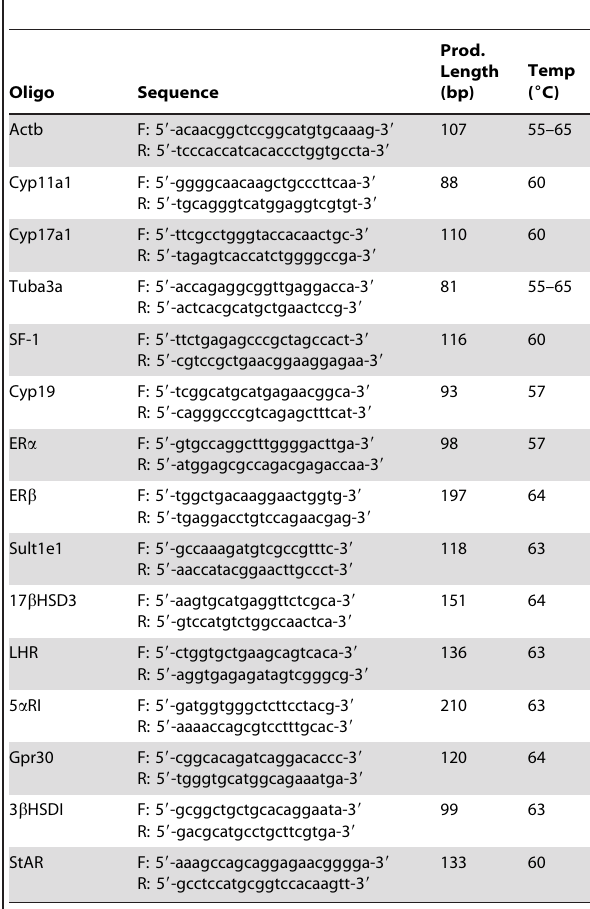
Table 1. qPCR primer sequences and running conditions, bp- base pair.